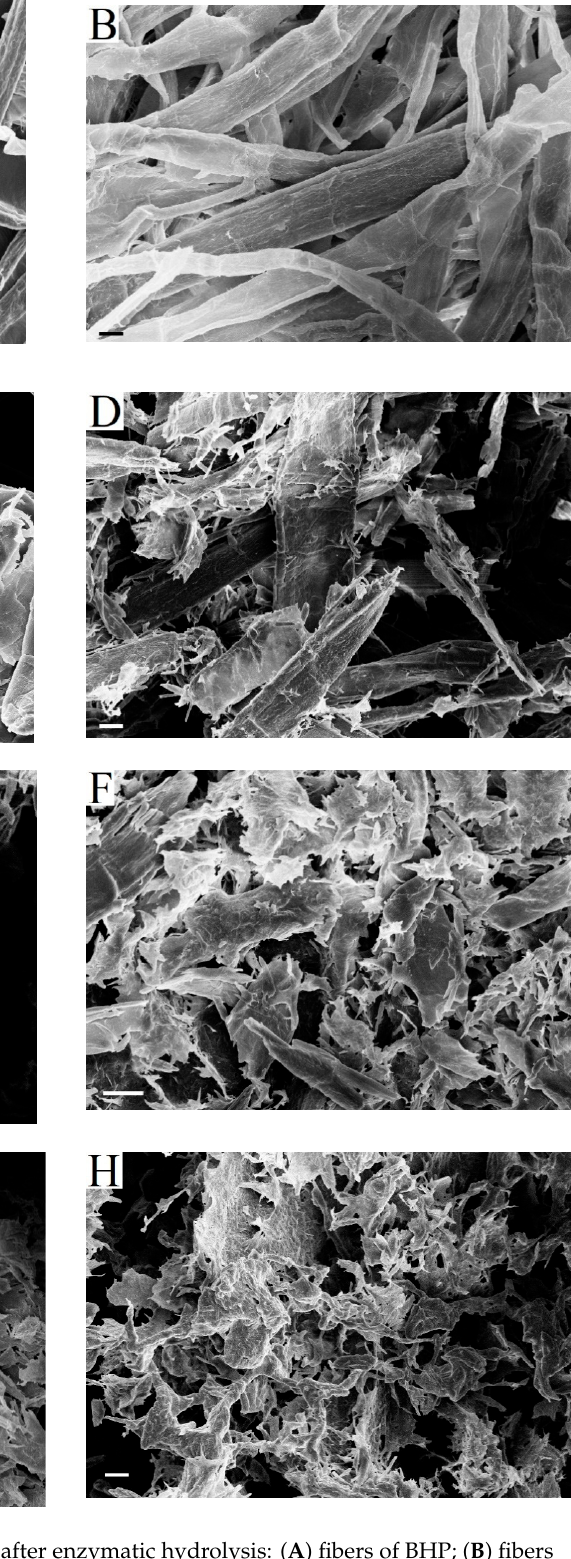
Figure 8. Fibers of BHP and SHP before and after enzymatic hydrolysis: ( A ) fibers of BHP; ( B ) fibers of BSP; ( C ) the BHP fiber after 3 h of enzymatic hydrolysis; ( D ) the BSP fiber after 3 h of enzymatic hydrolysis; ( E ) the BHP fiber after 8 h of enzymatic hydrolysis; ( F ) the BSP fiber after 8 h of enzymatic hydrolysis; ( G ) the BHP fiber after 24 h of enzymatic hydrolysis; and, ( H ) the BSP fiber after 24 h of enzymatic hydrolysis. Bars: ( A – H )—10 µ